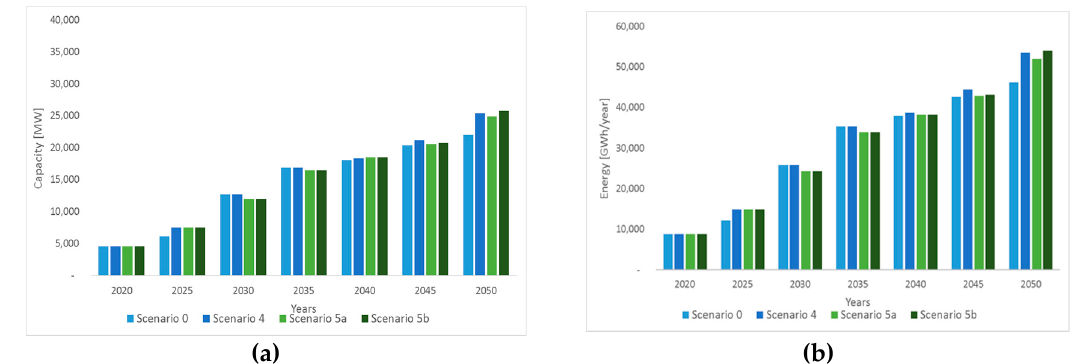
Figure 7. Evolution of the installed capacity ( a ) and energy generation ( b ) of PV and wind for Scenarios 4 and 5.